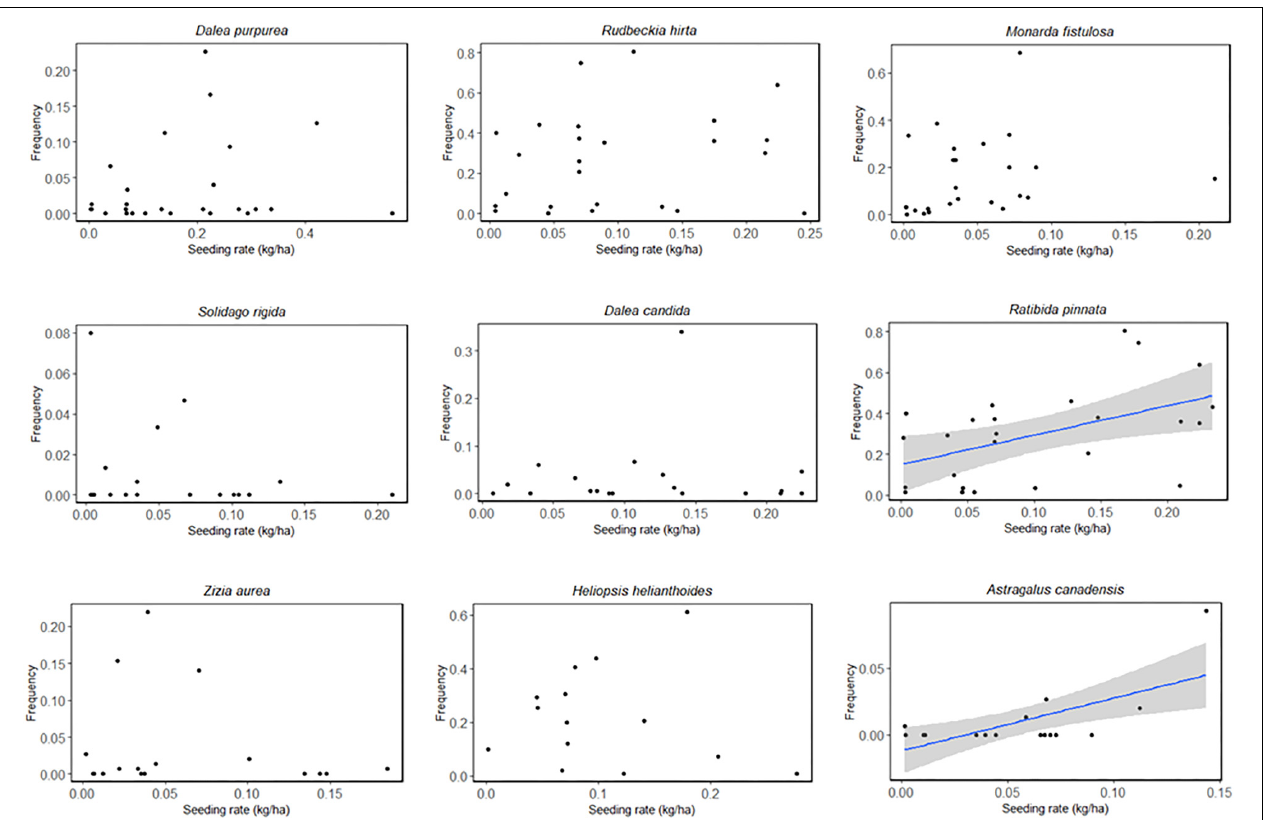
FIGURE 4 | Observed frequency of the most commonly planted forb species as a function of seeding rate (kg/ha PLS). Linear regressions with 95% confidence intervals are displayed only for species with statistically significant relationships between seeding rate and measured frequency ( p < 0.05). ( Symphyotrichum novae-angliae is excluded from the figure due to the fact that it was never detected within quadrats at sites in which it was planted. It was only detected during the meandering walk and therefore has frequency scores of